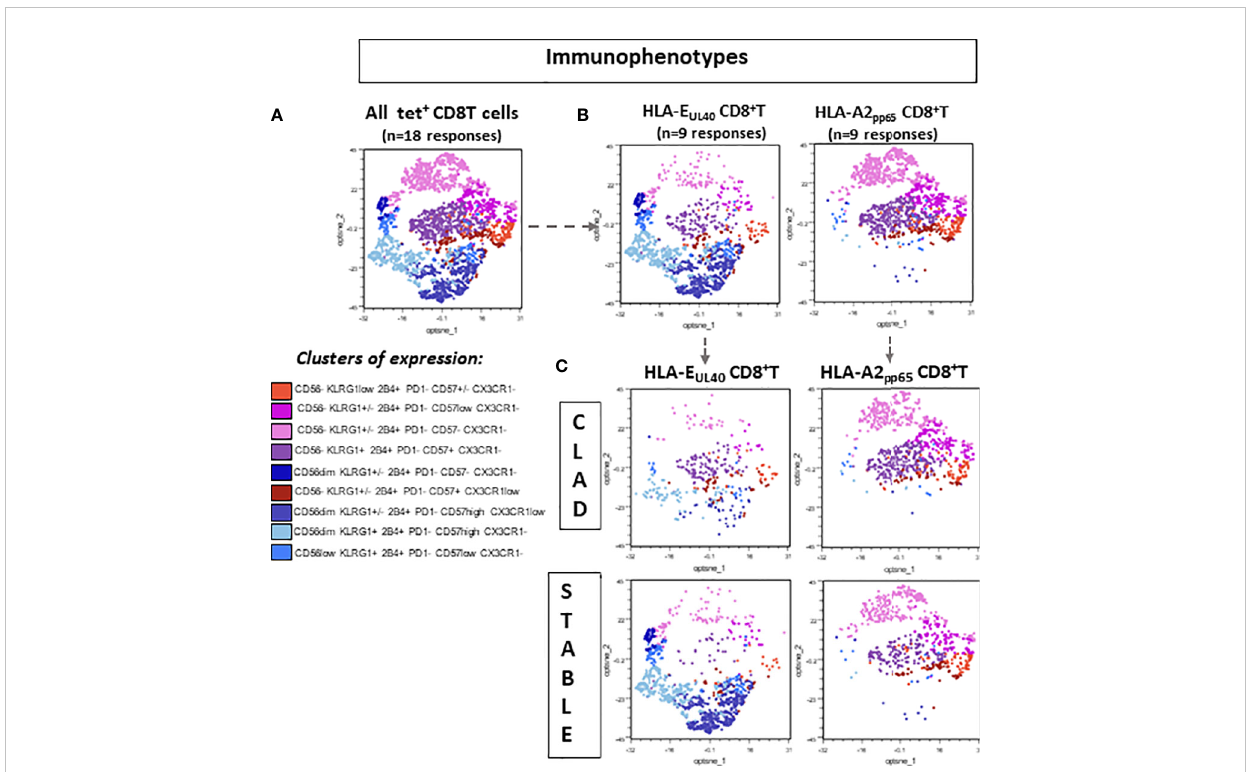
FIGURE 4 Distinctive signature of CLAD on the immunophenotype of memory EUL40 CD8 T cells. Spectral fl ow cytometry data were analyzed using a gating strategy depicted in Supplementary Figure S2 to identify tet + CD8 T cells. Next, tet + CD8 T cells were subgated to select CD3 + TCR gd − CD8 + tet + TEMRA (CD45RA + CCR7 − ) before clustering analysis. (A) 2D opt-SNE visualization of spectral cytometry data showing immunophenotypic patterns in pooled tet + CD8 TEMRA populations ( n = 18, consisting of nine EUL40 T subsets and nine A2pp65 T subsets). Nine clusters were identi fi ed based on the expression of CD57, CD56, CX3CR1, KLRG1, 2B4, and PD-1 as indicated. (B) 2D opt-SNE visualization of immunophenotypic patterns in A2pp65 versus EUL40 tet + CD8 TEMRA populations ( n = 9 for EUL40 T subsets and n = 9 for A2pp65 T subsets). (C) 2D opt-SNE visualization